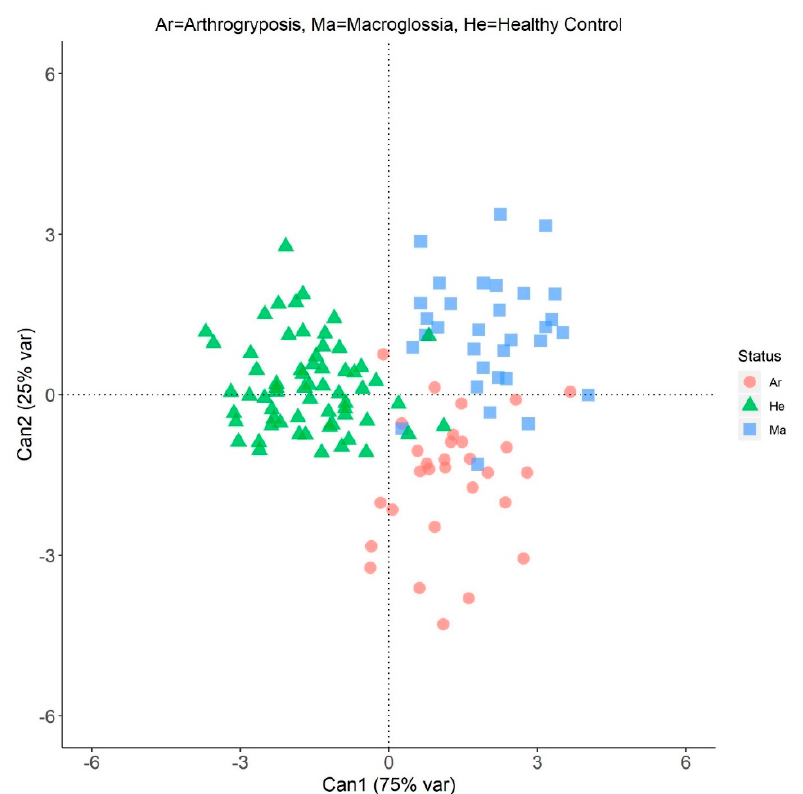
Figure 2. Plot of the individual scores on the two canonical variables (Can1 and Can2) depicted in di ff erent colors and symbols according to their health status.